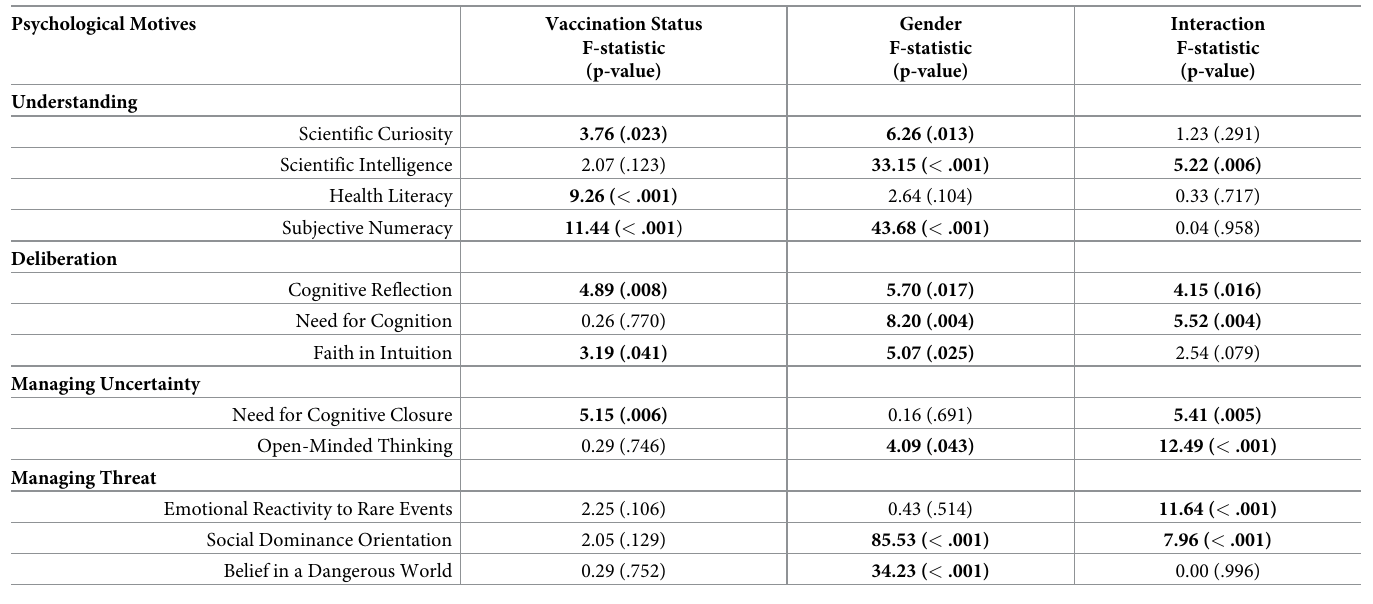
Table 6. Two-way ANOVAs testing associations and interactions of vaccination status and gender.